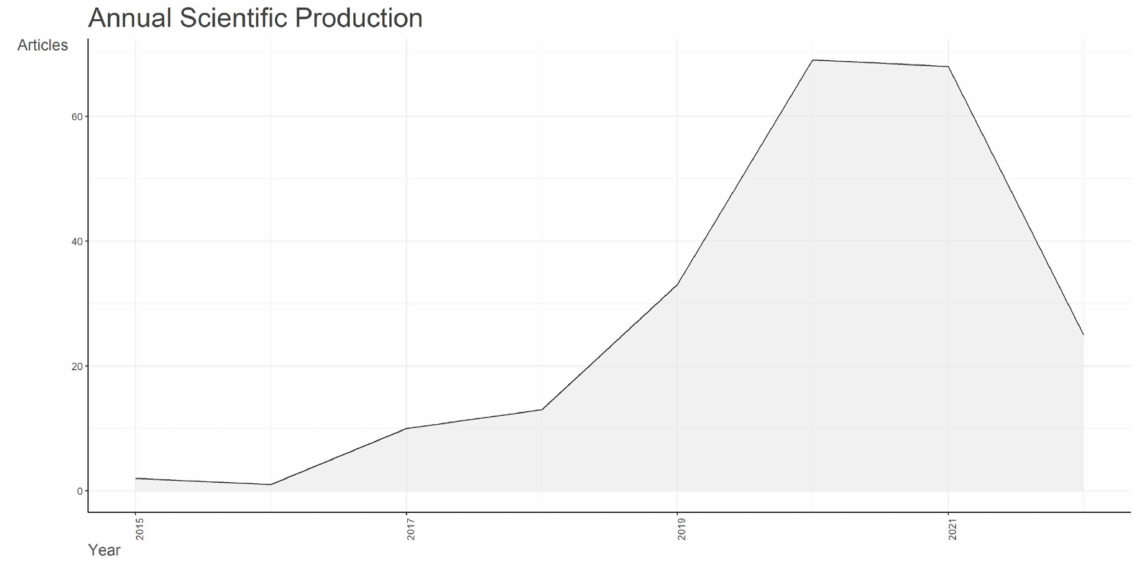
Figure 1. Annual Scientific Production.